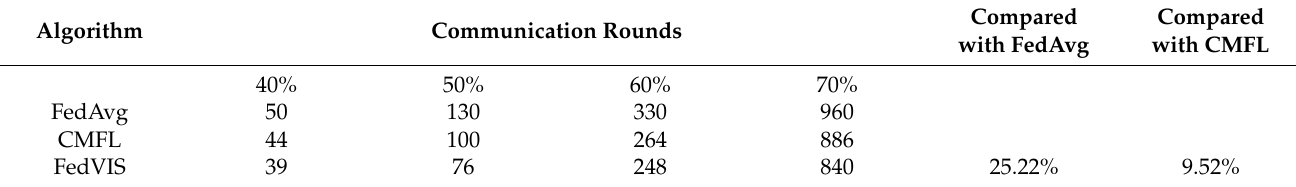
Table 4. The number of communication rounds required by FedAvg algorithm, CMFL algorithm, and FedVIS algorithm to reach the target accuracy at different correlation thresholds. The average number of communication rounds decreased compared with FedAvg, and the average number of communication rounds decreased compared with CMFL.